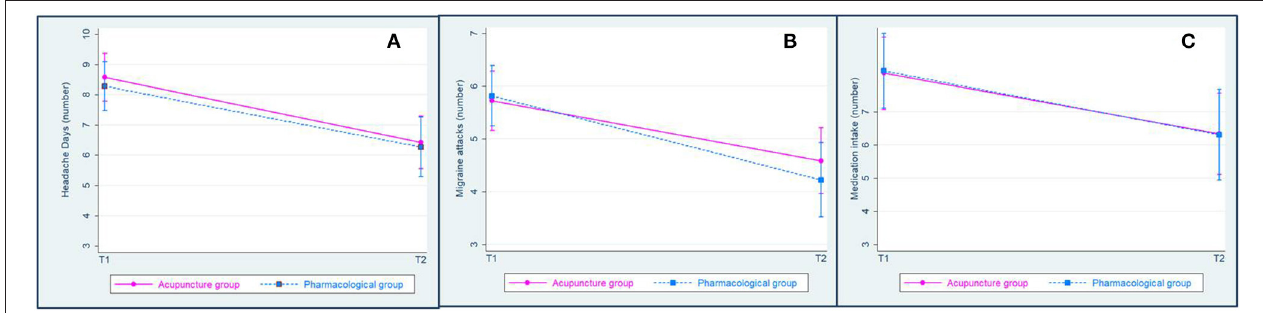
FIGURE 3 | Adjusted predictions of interaction between time (T1 and T2) and groups (acupuncture and pharmacological groups) on parameters with 95% confidence intervals. (A) Migraine days; (B) migraine attacks; (C) medication intake.